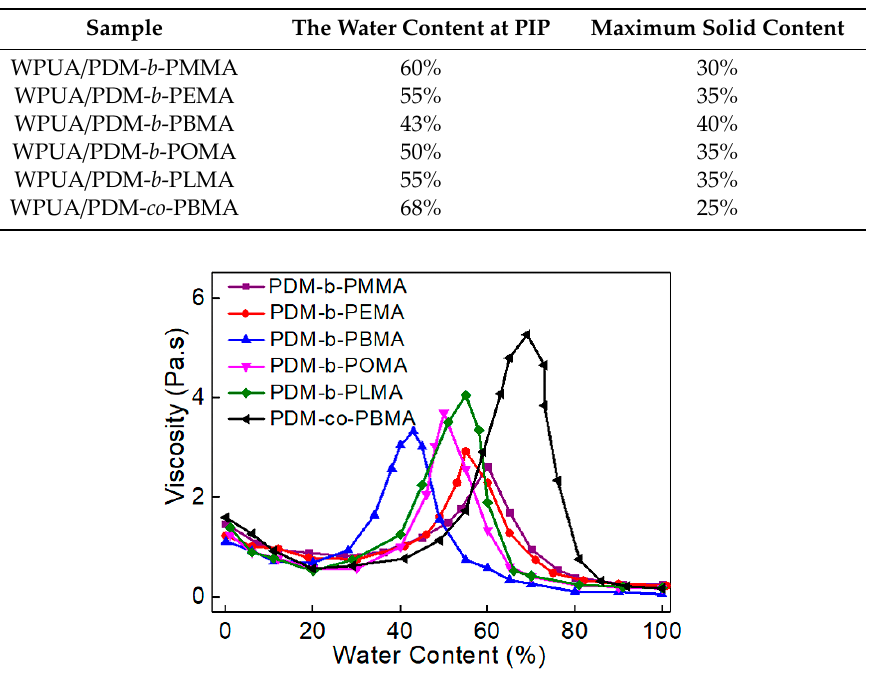
Figure 8. Influence of HSC length on the viscosity of PUA prepolymers during phase inversion process.